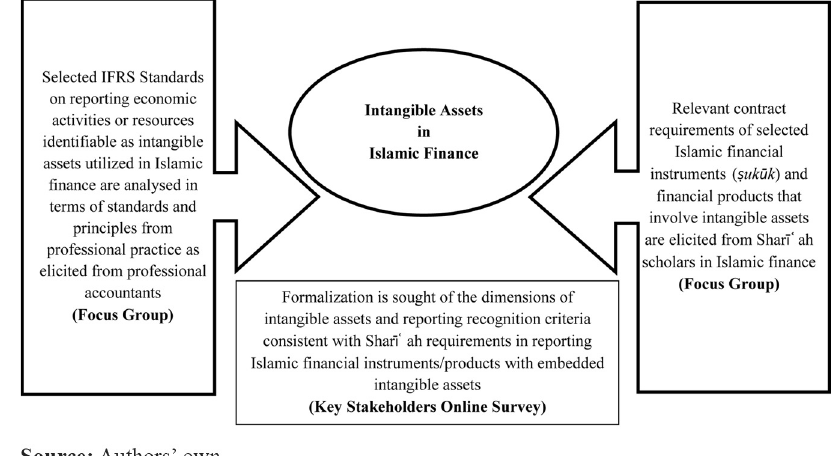
Figure 1. Proposed analytical